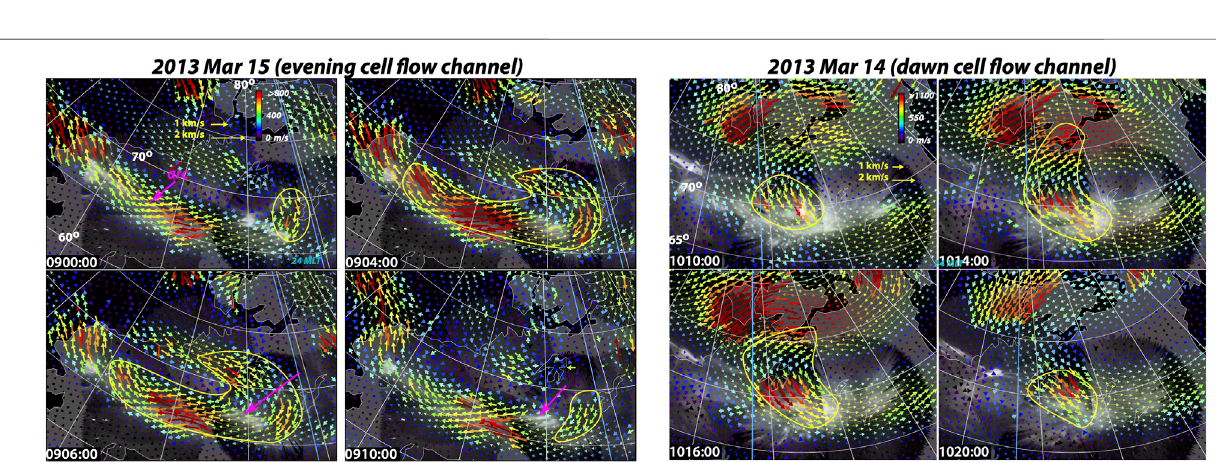
FIGURE5| Sameas Figure4 ,exceptforabetweencell fl owchannelonFebruary20,2014,andtheclosedyellowcurveapproximatelyencirclestheregionwhere fl ows were enhanced relative to that seen at 0800 UT.